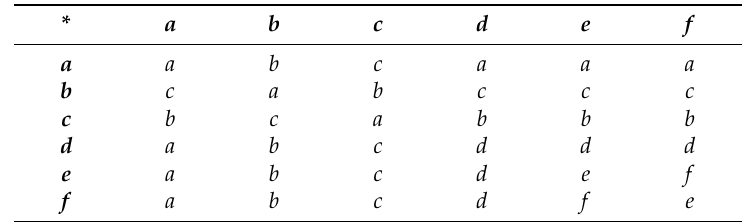
Table 5. The operation * on N